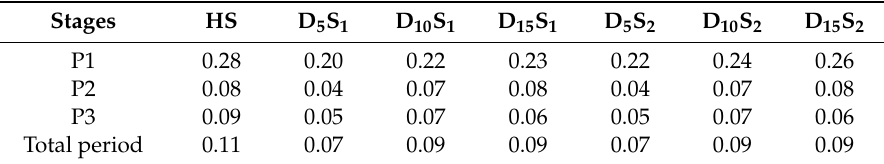
Table 3. Soil evaporation rates in homogeneous and sand-layered soil columns during di ff erent freeze–thaw stages (unit: mm · d − 1